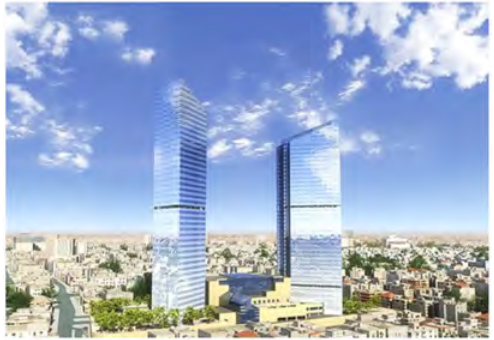
Figure 13. Jordan Gate (Amman Gate) project proposal. Source: Skyscrapercity.com (2006)